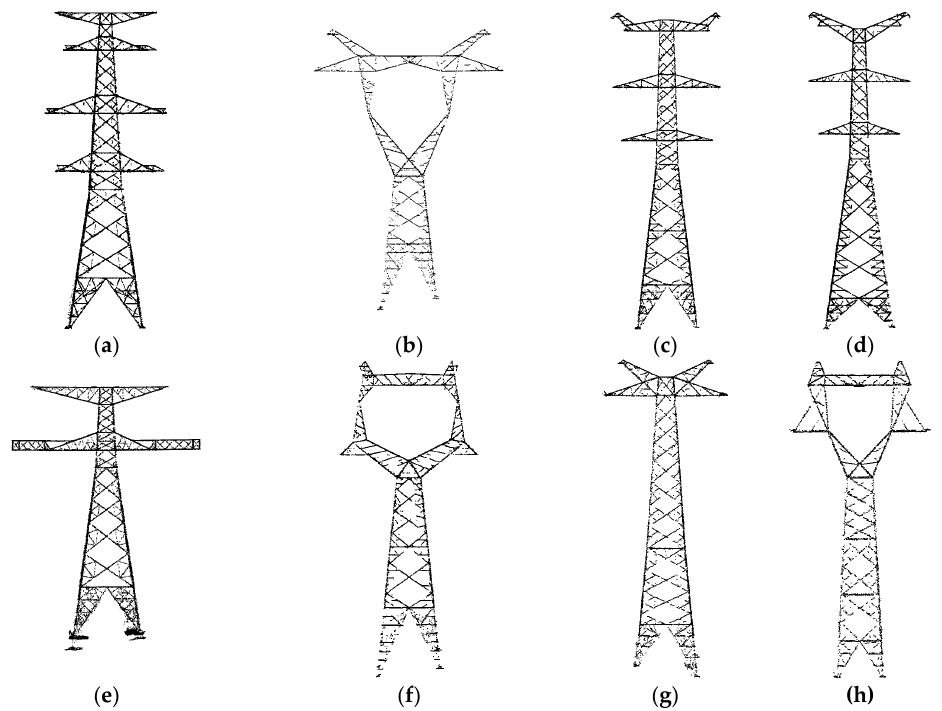
Figure 21. Original point cloud of multi-type pylons: ( a ) Pylon of Type a; ( b ) pylon of Type b; ( c ) pylon of Type c; ( d ) pylon of Type d; ( e ) pylon of Type e; ( f ) pylon of Type f; ( g ) pylon of Type g; ( h ) pylon of Type h. Table 5. Details about pylon points.